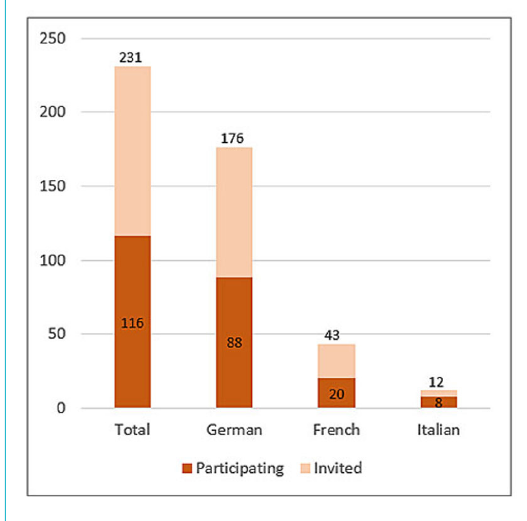
Figure 2: Invited and participating hospitals by language region.